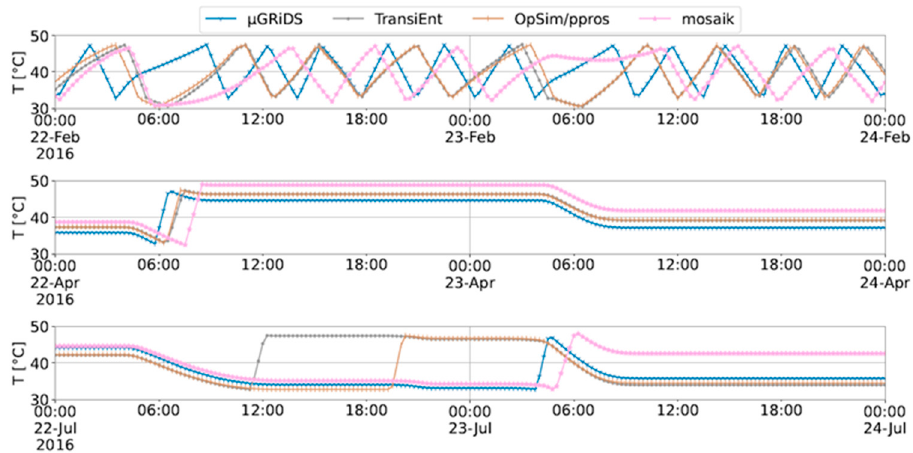
Figure 8. Mean temperature of the hot water storage for two days in February (winter), April (transition) and July (summer). Compared are the different results among the four models involved.